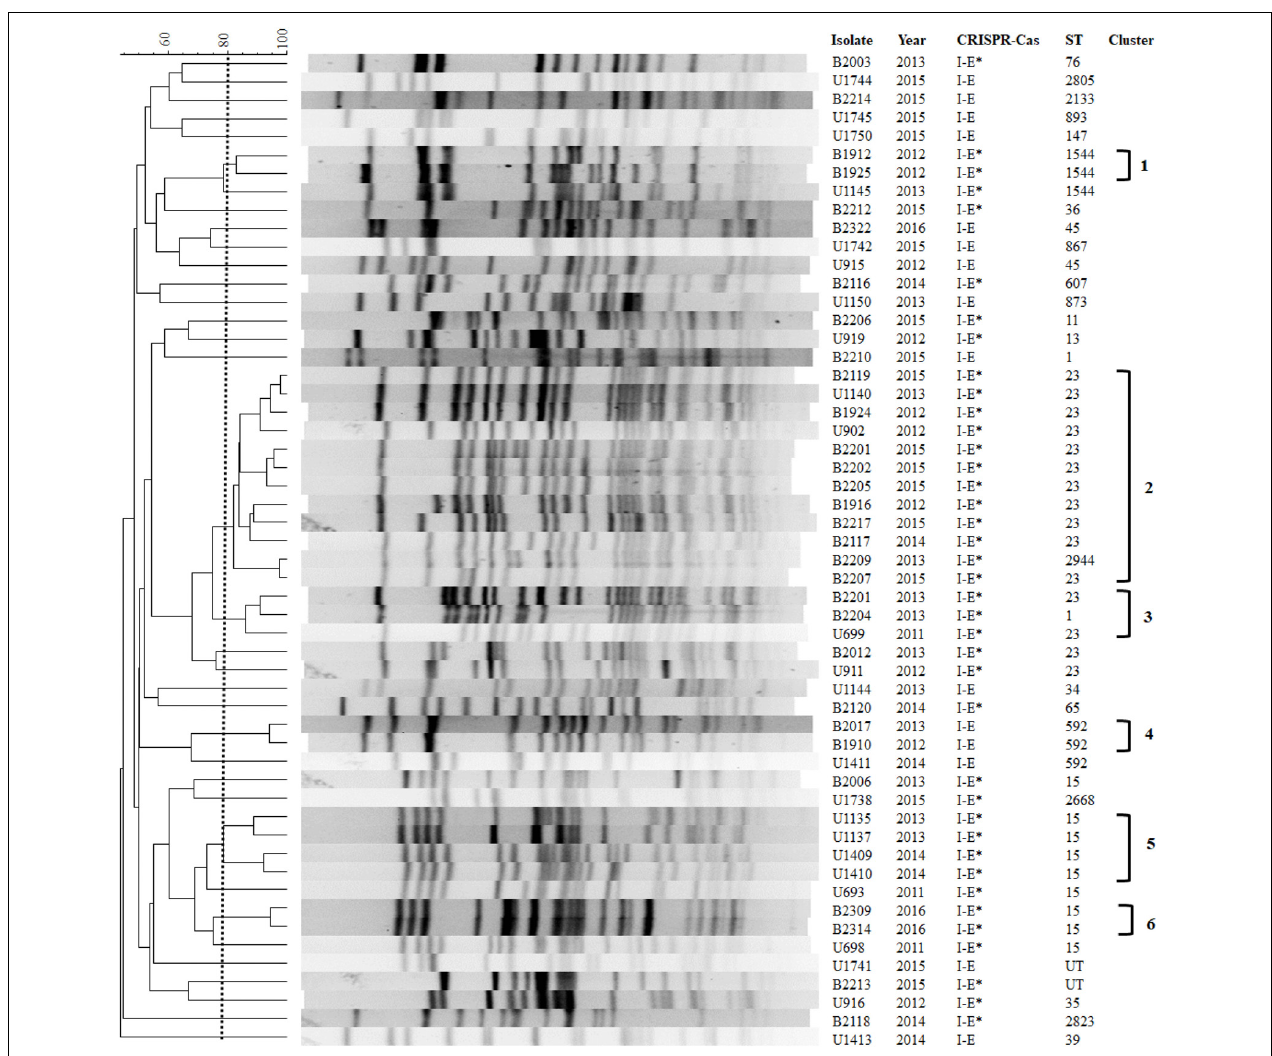
FIGURE 2 | Pulsed-field gel electrophoresis (PFGE) patterns, CRISPR-Cas systems, and STs among 54 clinical K. pneumoniae isolates. The first letter of the name of isolates is based on the origins of isolate. U, urinary tract infection; B, bloodstream infection; UT,